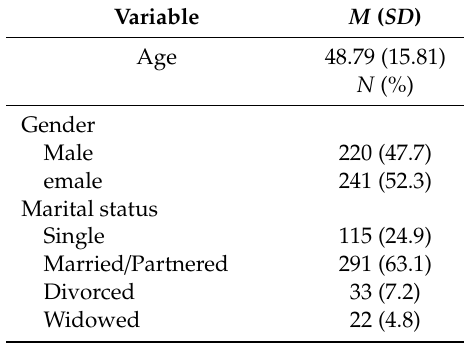
Table 1. Sociodemographic characteristics of participants ( N =